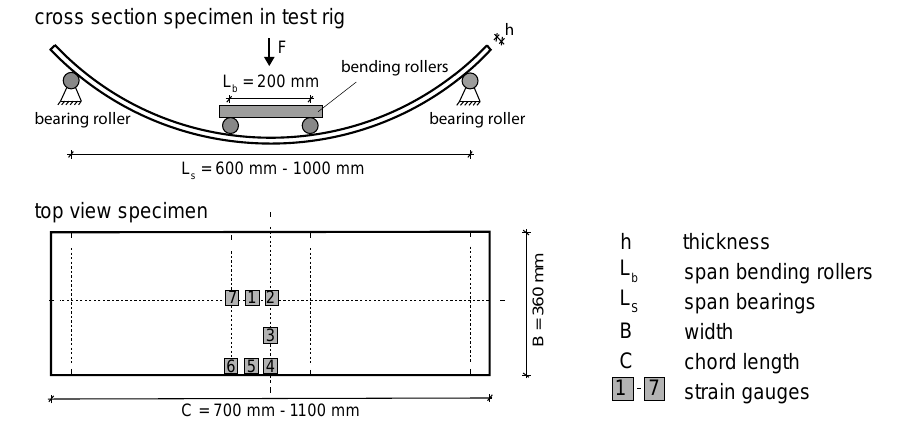
Fig. 3 Specimen cross section and top view of assembly of the strain